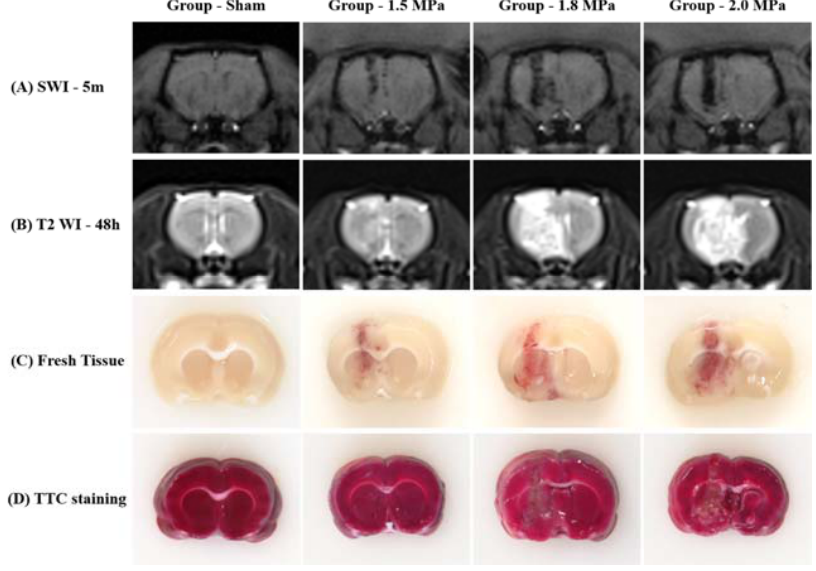
Figure 2. Representative MR images, fresh tissue and triphenyltetrazolium chloride (TTC) staining ( A ) SWI, ( B ) T2 WI, ( C ) Fresh tissue slice, and ( D ) TTC staining.